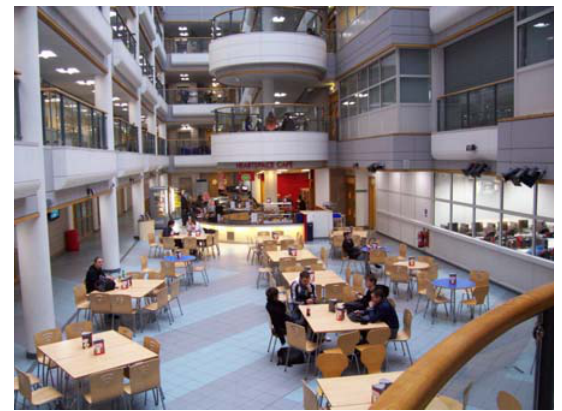
Figure 11. Northern Europe atrium—lower café